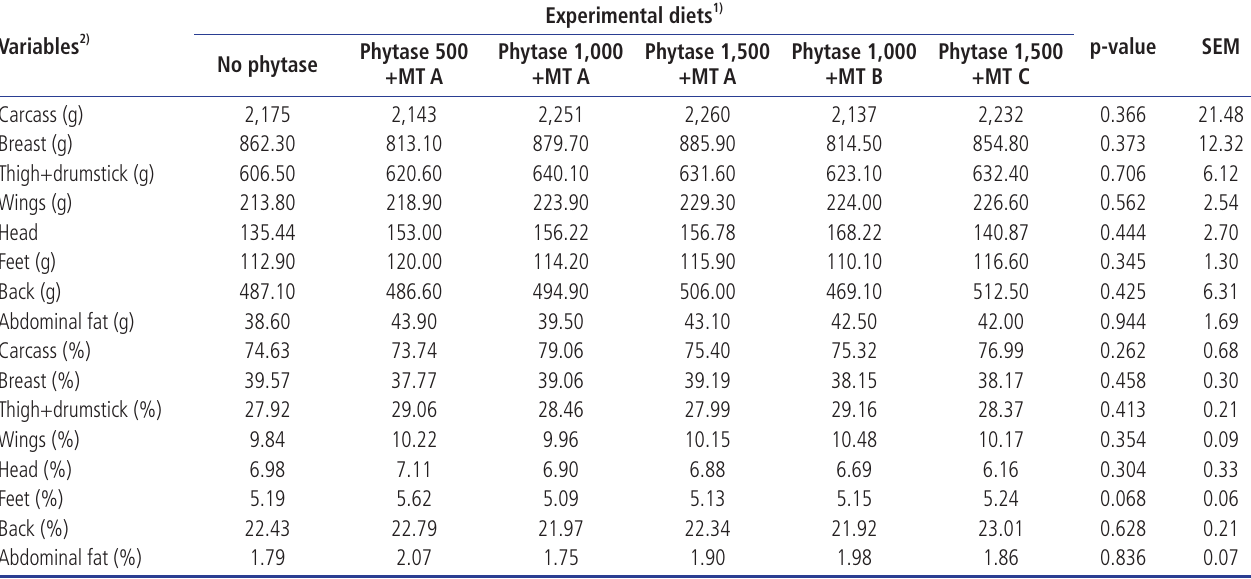
Table 8. Carcass characteristics and cut yields of broilers fed diets supplemented with phytase at 42 days of age Variables